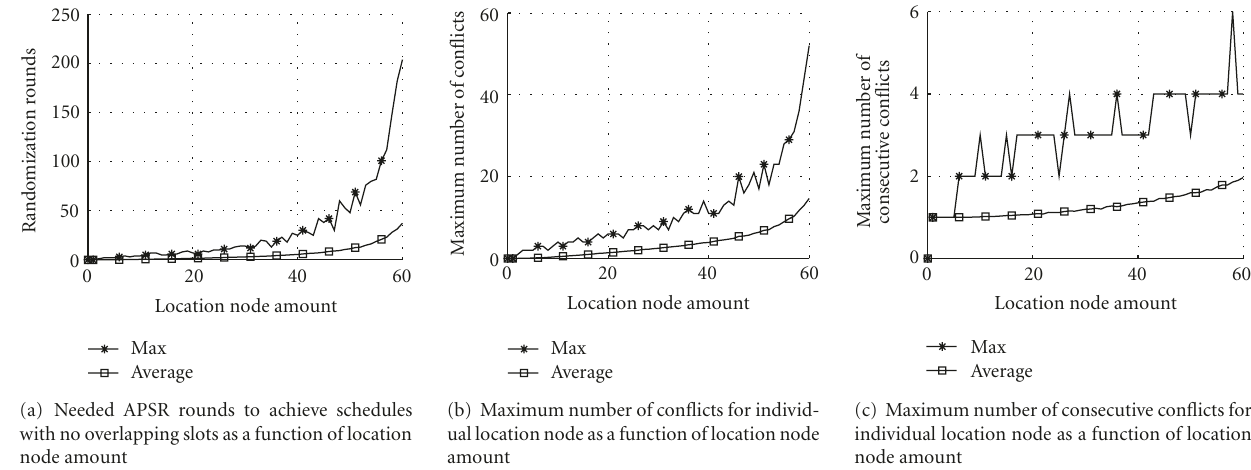
Figure 17: Active period slot randomization procedure performance with di ff ering amount of location nodes, 2-second beacon cycle.